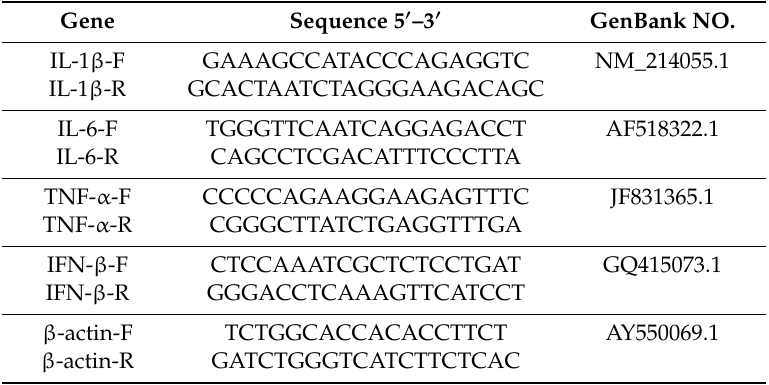
Table 2. Primers used for Real-time